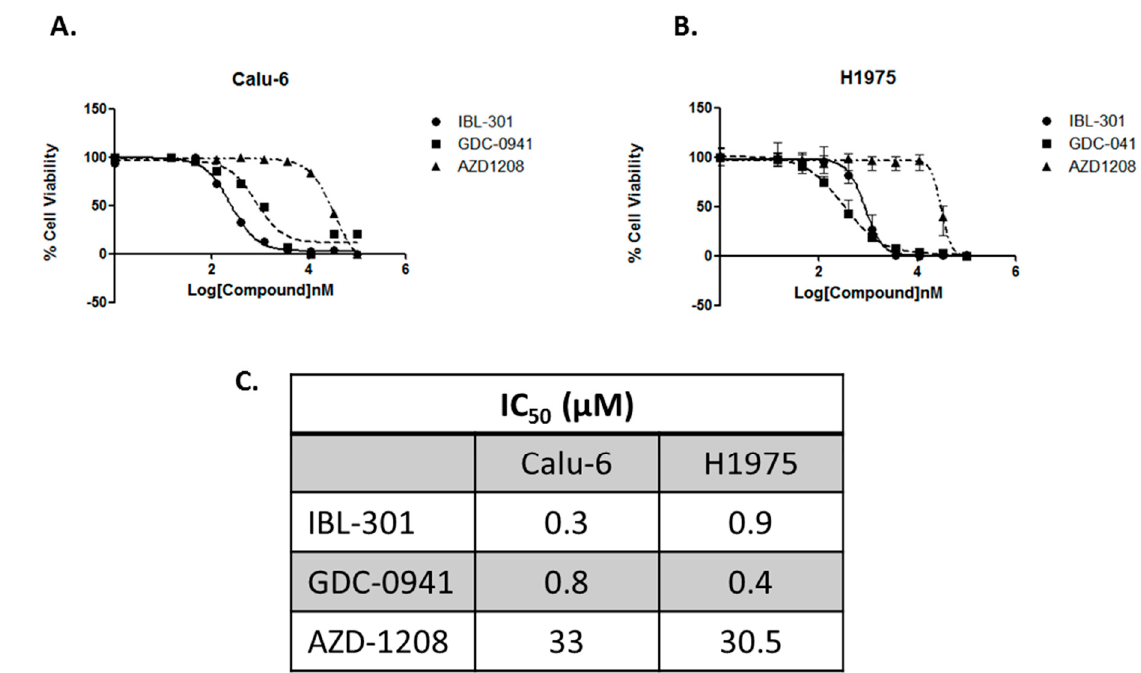
Figure 2. Dose response curves of IBL-301, GDC-0941 and AZD1208 in Calu-6 and H1975 cell lines. The dose response effect of triple targeted PI3K/mTOR/PIM inhibitor (IBL-301), pan-PI3K inhibitor (GDC-0941) and pan-PIM kinase inhibitor (AZD1208) (100 µM, 33.33 µM, 11.11 µM, 3.70 µM, 1.23 µM, 0.41 µM, 0.13 µM, 0.04 µM, 0.01 µM and DMSO vehicle) on cell viability over 72 h was measured by CellTiter-Glo ® assay in ( A ) Calu-6 and ( B ) H1975 cell lines. Values are reported as mean ± SEM ( n = 2). ( C ) IC50 values were calculated representing the percentage of inhibition against compound concentration and adjusting the experimental data to sigmoidal curve using the software GraphPad Prism 5.01.